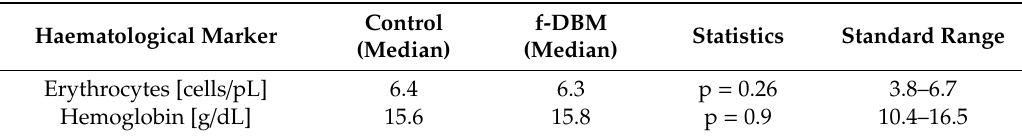
Table 2. Hematological results of both groups: Significantly increased percentage of neutrophilic granulocytes, significantly reduced percentage of lymphocytes in operated animals after two months of standing. Standard ranges by Delwatta et al.